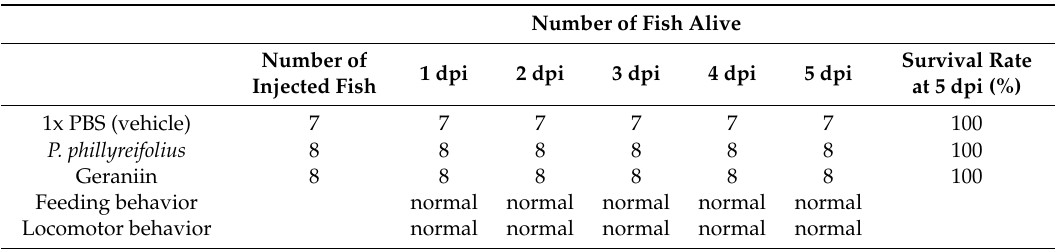
Table 2. Survival and behavior of fish injected with Phyllanthus phillyreifolius extract and geraniin from 1 day post injection to 5 days post injection